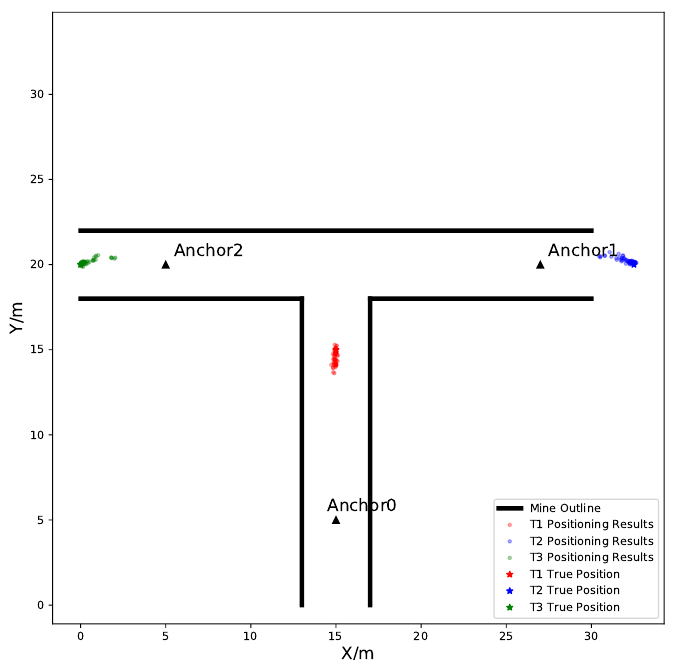
Figure 16. Localization results of the static experiment.